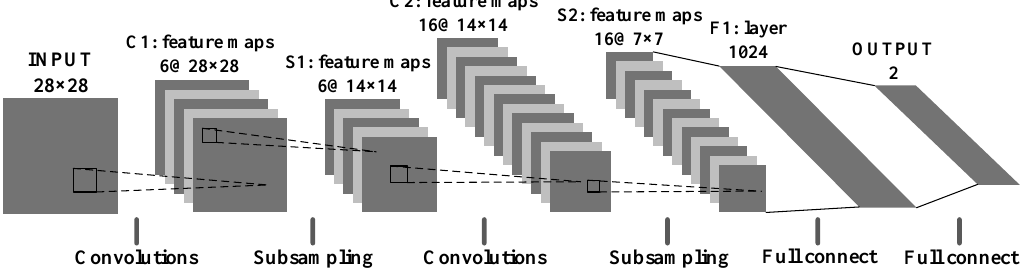
Figure 11. Topology of the LeNet-F model.